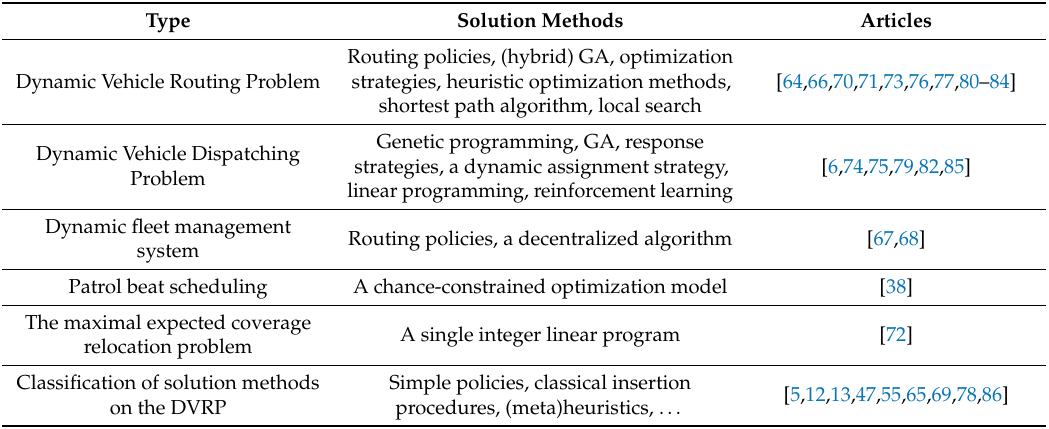
Table 1. Overview of the di ff erent types of problems and their solution